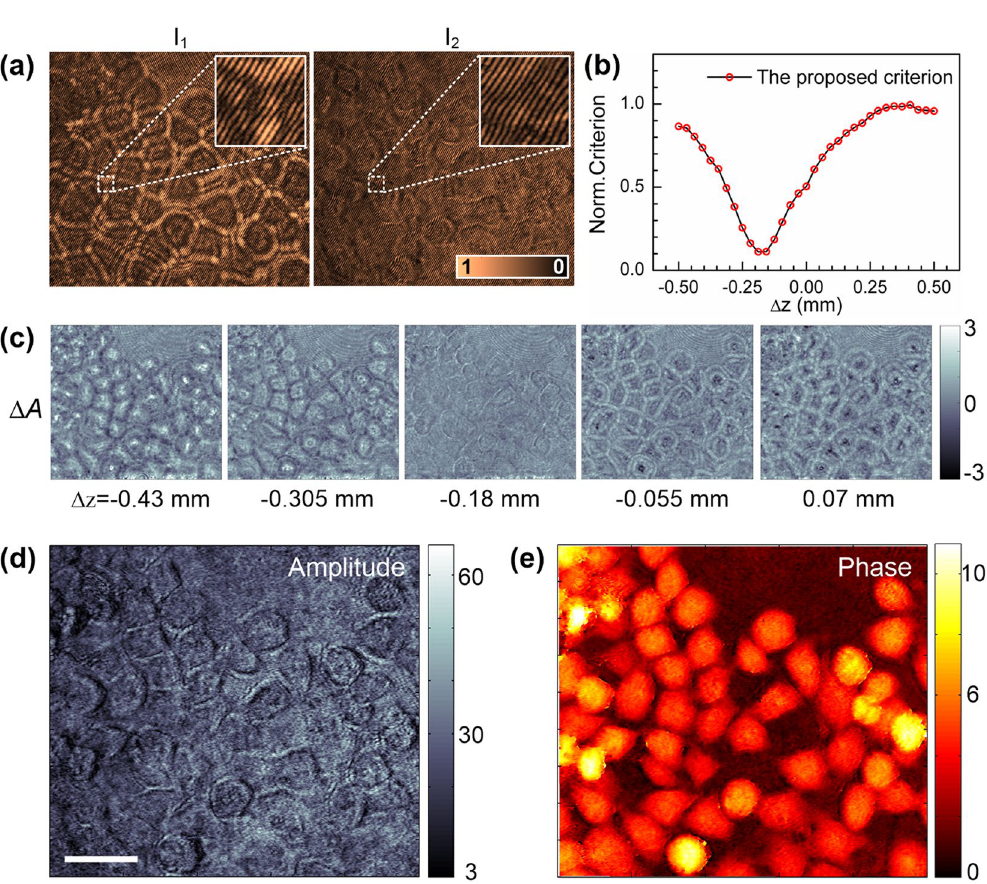
Figure 5. OV-DHM for Hela cells. ( a ) Two opposite-view holograms of the two object waves O 1 and O 2 . Insets show the zoomed rectangular areas within the white close-ups in ( a ). ( b ) Focus criterion curves calculated with the proposed method. ( c ) The difference between the amplitudes of | O 1 | and | O 2 |. ( d ) Reconstructed amplitude and ( e ) phase of the object wave O 1 . Scale bar in ( d ), 45 μ